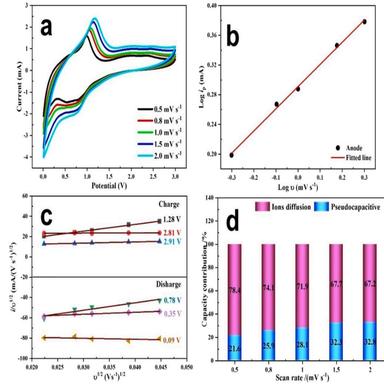
SM-BFO electrode: (a) CV curves at different current densities, (b) the relationship between log ip and log υ, (c) the relationship between i/υ1/2 and υ1/2, (d) capacity contribution at different scan rates.